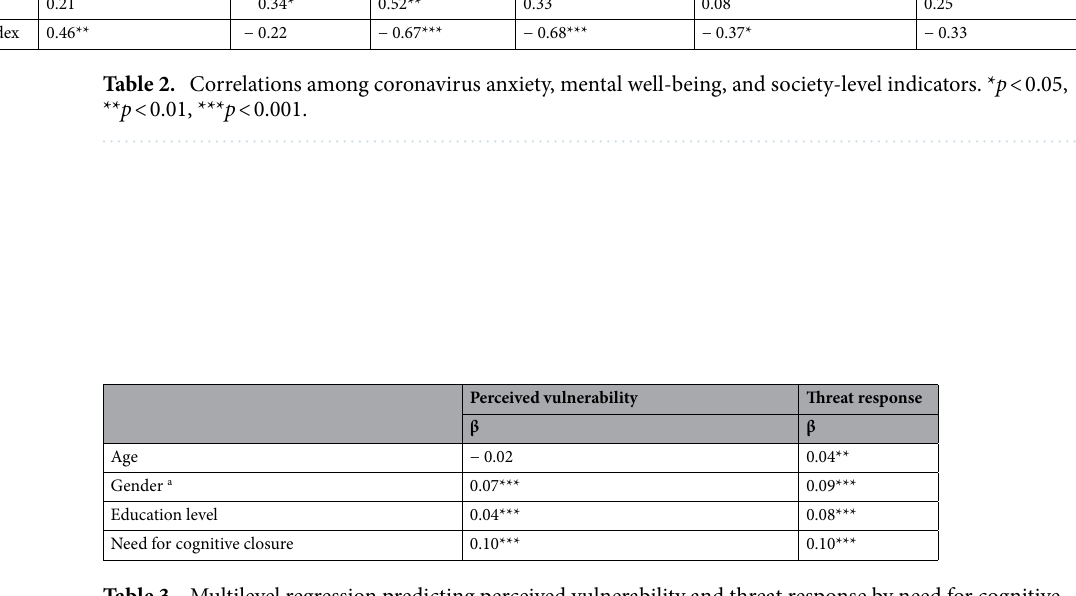
Perceived vulnerability Threat response Self-rated health Subjective well-being